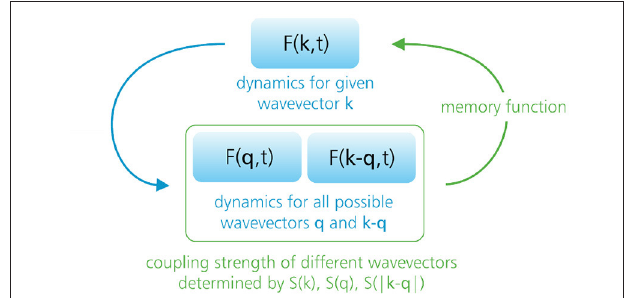
FIGURE 5 | Sketch of the MCT equations. The theory seeks to predict the full dynamics of the intermediate scattering function F ( k , t ) for all possible wavevectors k and all times t . The exact F ( k , t ) dynamics is governed by a memory function that, within standard MCT, is approximated as a product of two intermediate scattering functions that probe density correlations at different wavevectors q and k − q . The couplings among the different wavevectors { k , q , k − q } are determined by the so-called vertices, which depend explicitly on the static structure factor. Hence, the static structure factor must be given as input to the theory, and dynamical information is given as